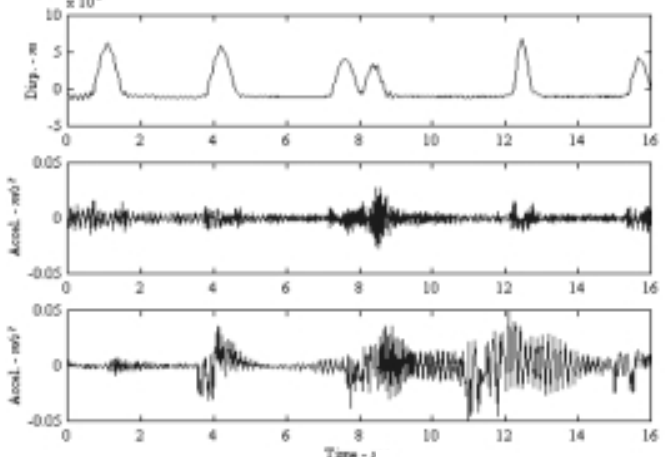
Fig. 5. Comparison between direct measurement of displacement (upper plot) by laser vibrometer, its second derivative (middle plot) and accelerometer signal (lower plot).